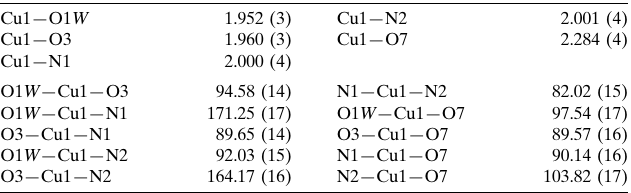
Selected geometric parameters (A˚ , (cid:2) ).